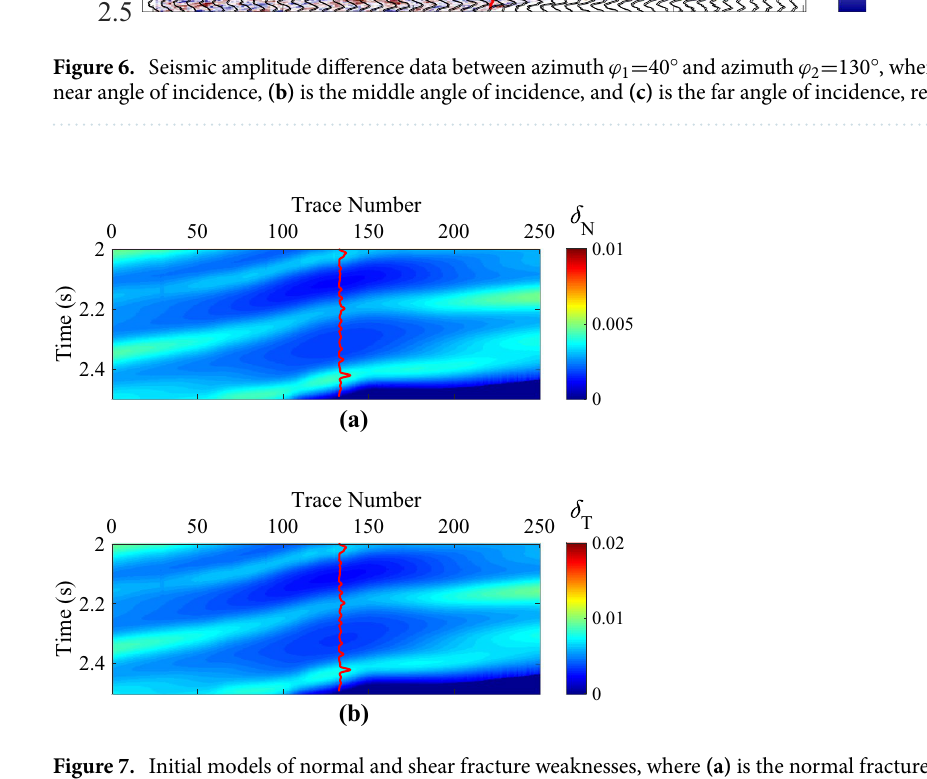
Figure 7. Initial models of normal and shear fracture weaknesses, where (a) is the normal fracture weakness, and (b) is the shear fracture weakness,